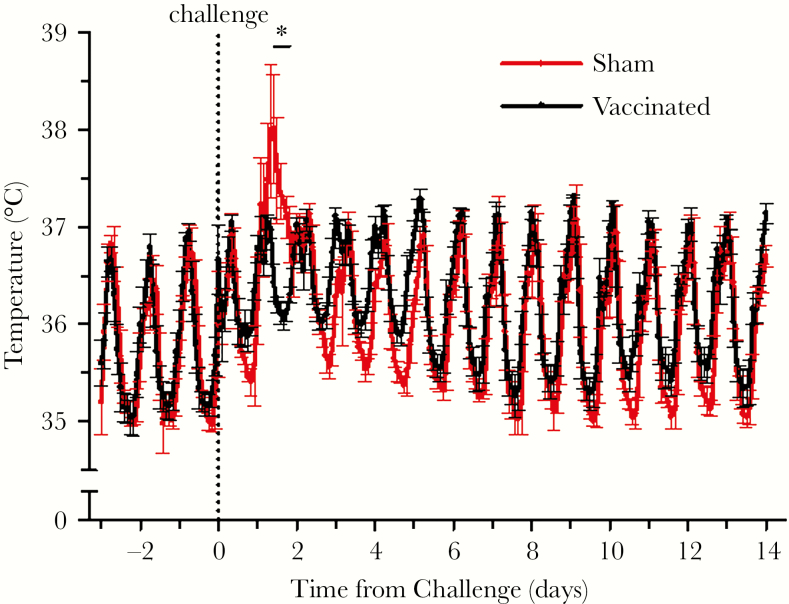
Body temperatures generated using a 2-hour moving average obtained from telemetric data. The vaccinated versus sham-vaccinated groups were compared statistically by one-way analysis of variance followed by Tukey’s test at each 2-hour time point beginning from 24 to 48 hours postchallenge. The mean temperature of the sham-vaccinated animals was significantly (P < .05) higher between 34 to 44 hours postchallenge as indicated by the asterisk.